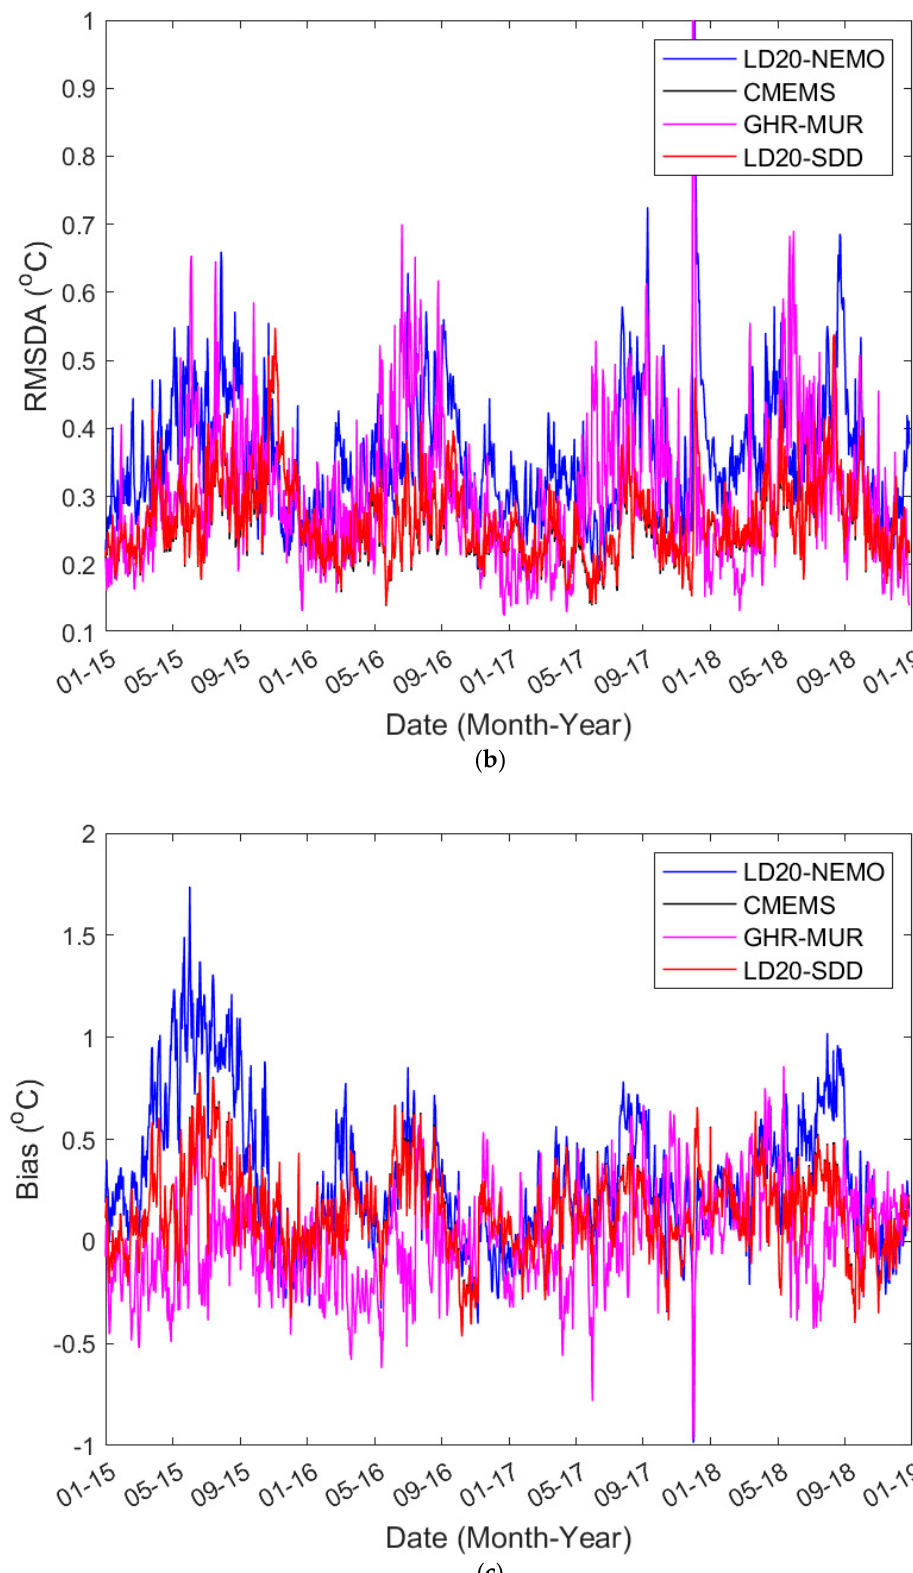
Figure 5. Time series of skill parameters for the temperature for different data sets (LD20-SDD, LD20-NEMO, CMEMS and GHR-MUR) compared with OSTIA: ( a ) RMSD for actual values, ( b ) RMSDA for anomalies, ( c ) Bias. Skill parameters are defined in Equations